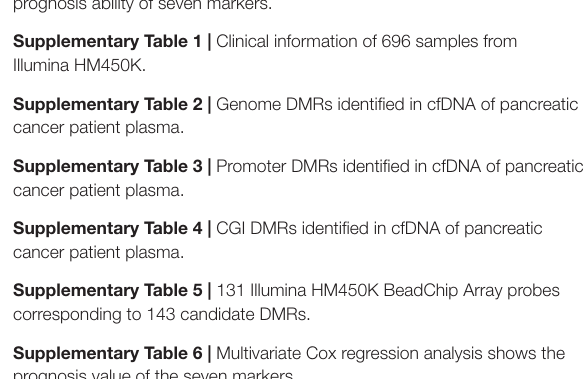
Supplementary Figure 1 | Representative bioanalyzer profiles of cfDNA and MeDIP-seq libraries. Supplementary Figure 2 | Kaplan–Meier analysis of PAAD patients revealed the prognosis ability of seven markers. Supplementary Table 1 | Clinical information of 696 samples from Illumina